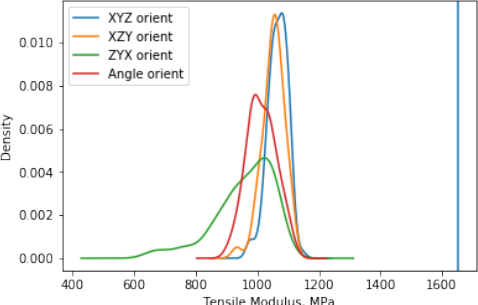
Figure 4. Distribution of tensile modulus for different orientations based on kernel distribution estimation (The straight line (1650 MPa) corresponds to the value from the EOS Balanced